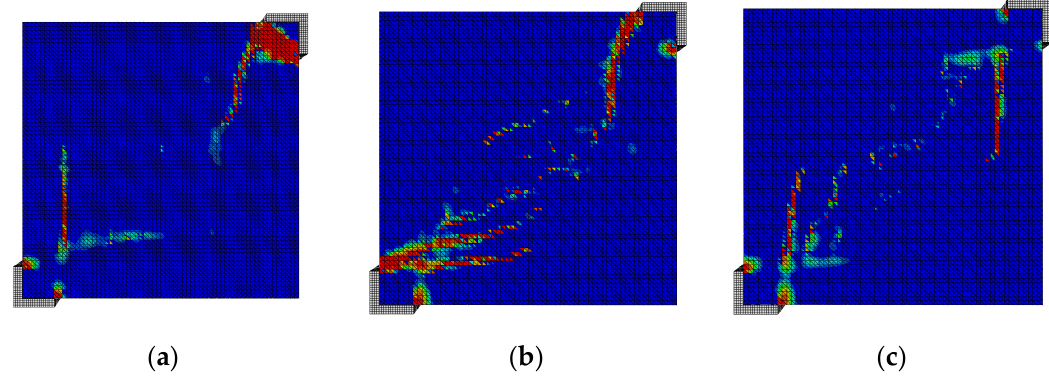
Figure 28. Damage pattern at the peak load of compression for ( a ) fc20, ( b ) fc30, ( c ) fc40.